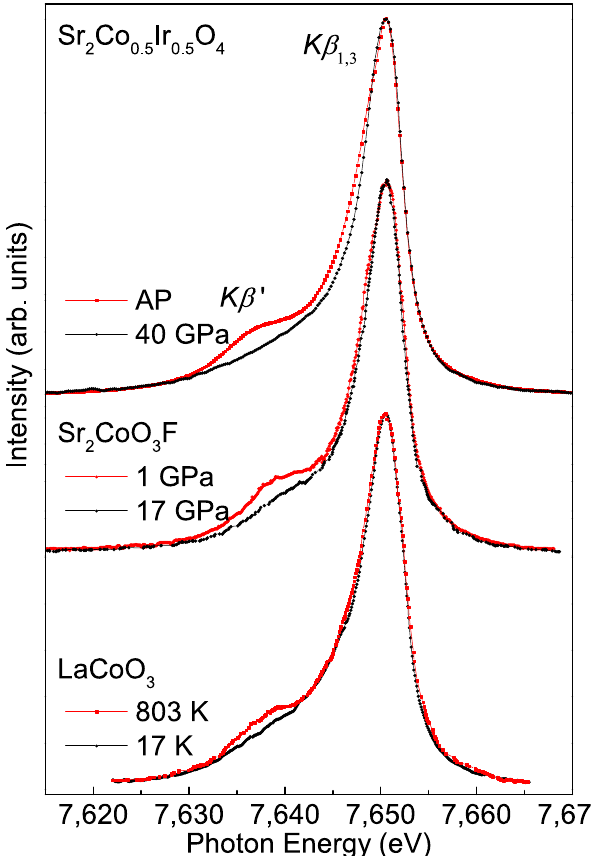
Figure 4. Co K β X-ray emission spectra (XES) of Sr 2 Co 0.5 Ir 0.5 O 4 at ambient pressure (red line) and 40 GPa (blue line) together with those of